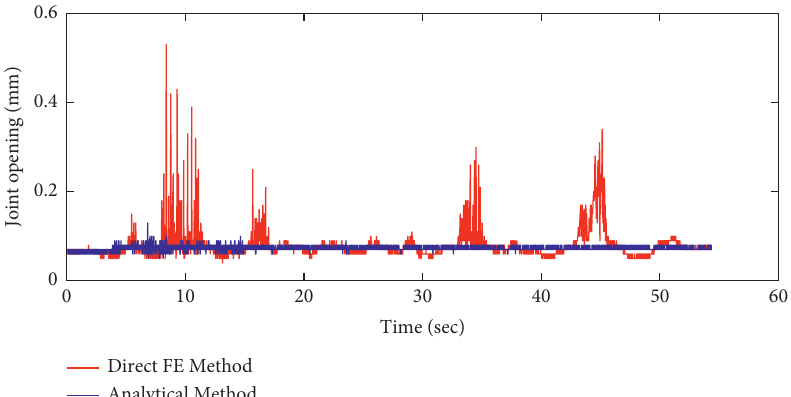
Figure 16: Time history of joint opening at joint 7 th induced by the Taft earthquake for foundation modelling using the direct FE method, analytical method, and the massless